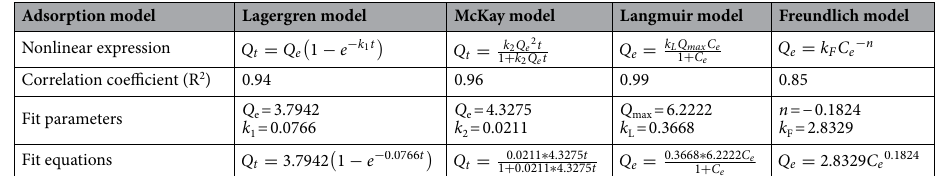
Table 5. Summary of non-linear fitting parameters of kinetic model.